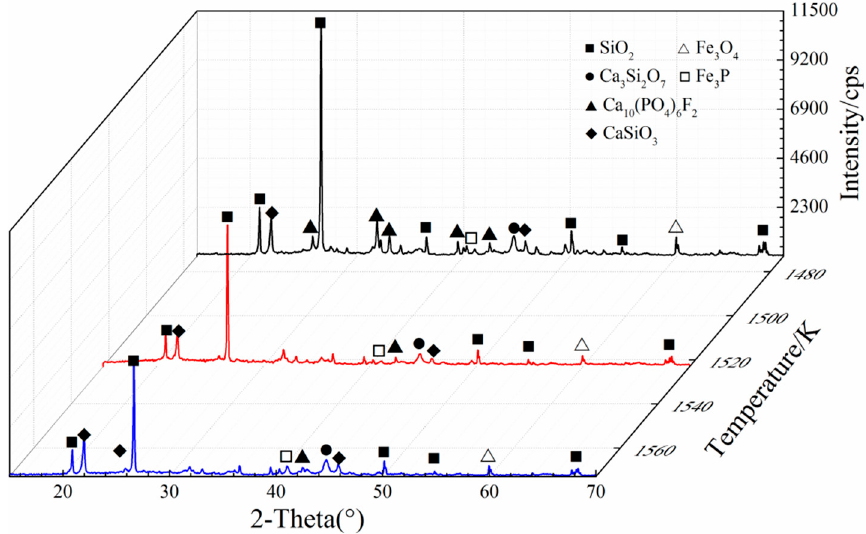
Figure 10. XRD pattern of the product of reduction at different temperatures in the Ca 10 (PO 4 ) 6 F 2 – SiO 2 –Fe 2 O 3 –C